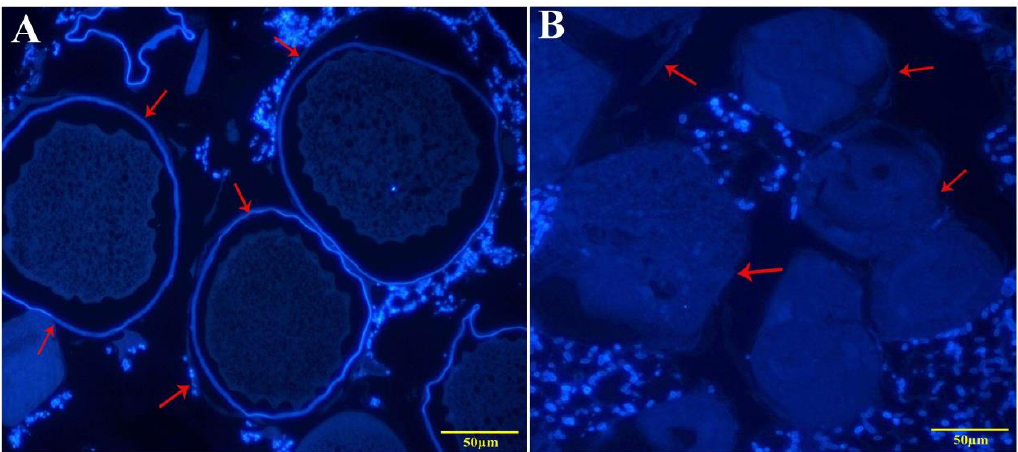
Figure 11. Fluorescence microscopy of the cuticular chitin presence in adult P. citri treated with ( A ) dsRNA- egfp (control gene); and ( B ) dsRNA- PcCHS1 (target gene). The arrow heads indicate the alterations in the epidermises and cuticles of P. citri adults.